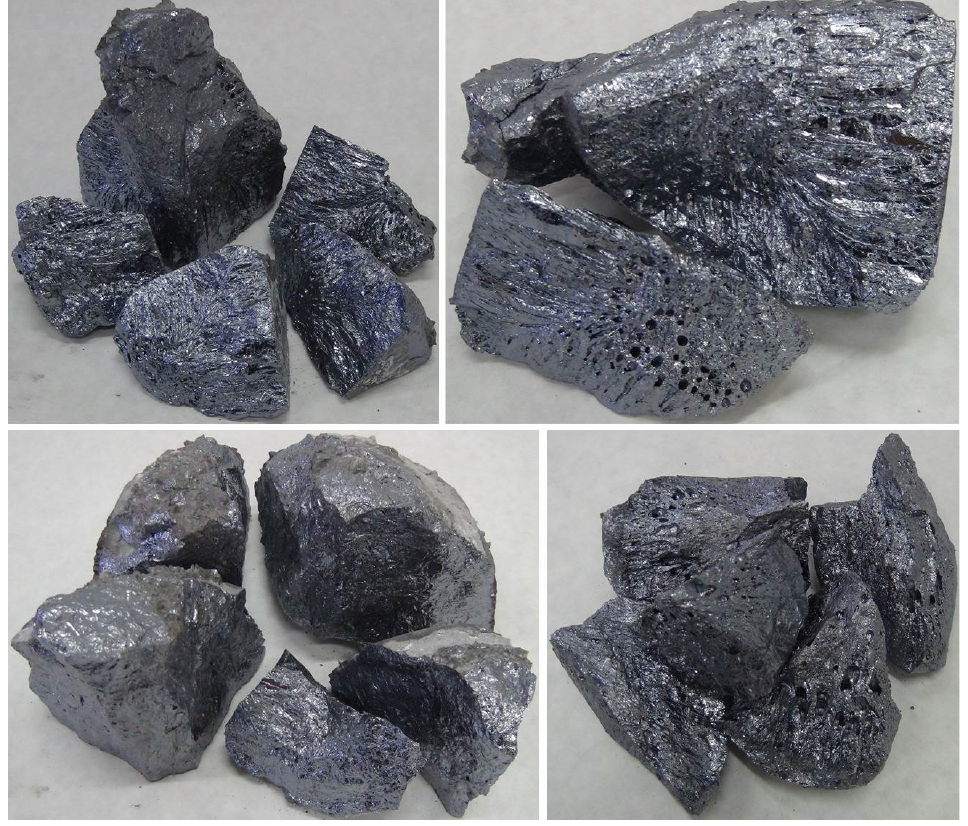
Figure 2. Photos of 4 purified MG-Si ingots obtained after the slag refining process.